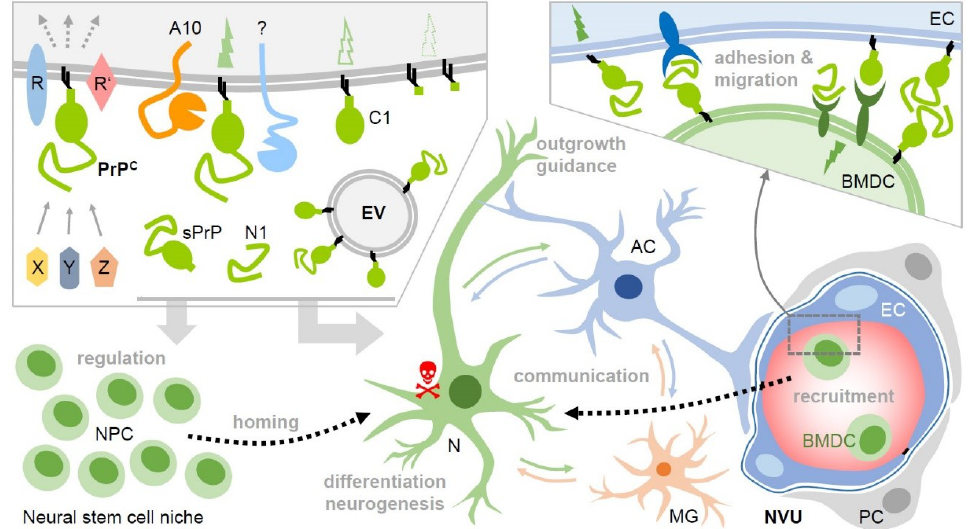
Figure 2. Potential roles of membrane-bound and released PrP (fragments) in intercellular communication and regenerative processes upon stroke. Upper left box: Various soluble ligands (X, Y, Z) and interaction partners have been described to bind to cell surface PrPC, which then, in complex with other membrane proteins (R, R’), induces cell type- and context-dependent signaling with diverse functional consequences. PrPC undergoes conserved cleavages at specific sites by ADAM10 (A10) and other proteases. This creates truncated membrane-bound forms (e.g., C1) and may modify or terminate PrP`s functions on the very same cell. Of note, soluble fragments, such as shed PrP (sPrP) or N1 are generated. Together with PrP enriched on and released via extracellular vesicles (EVs), this creates a pool of diverse PrP versions in the extracellular space. Upon stroke, PrP expression is upregulated in the penumbra and cell surface PrP (fragments) as part of signaling-competent receptor complexes and released forms (acting as bioactive ligands) may play decisive roles in neuroprotection and regeneration. For instance, they play a role in the regulation of stem cells, particular neural precursor cells (NPCs), and may be involved in the recruitment (‘homing’) to the site of hypoxic injury and differentiation/neurogenesis therein. PrP-associated neuroprotection may also relate to stimulated communication between neurons (N), astrocytes (AC), microglia (MG), and other cell types. This may, among other aspects, induce cellular repair mechanisms in support of damaged neurons (red skull) and support axon guidance and neurite outgrowth. PrP and its fragments also seem to be critically involved in the recruitment of bone marrow-derived cells (BMDC) from the periphery, which, similarly to NPCs, may replenish cells lost in the damaged brain tissue. They may also support angiogenesis (not depicted here). Again, this could be associated with PrP versions acting as ligands and/or receptors (even homophilic interactions are conceivable), allowing BMDC to dock to endothelial cells (EC) and migrate through the vessel into the damaged tissue (see bottom left part and box above; NVU: neurovascular unit; PC: pericyte). Note that many of these aspects are speculative at present and that several other molecules clearly play important roles in these processes. This scheme aims to present a PrP-focused view to simplify matters. Key references are provided in the main